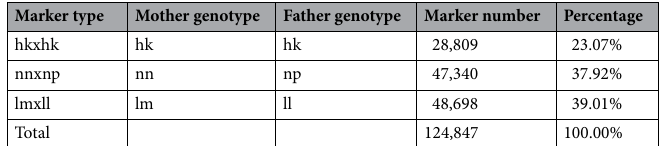
Table 2. Number of genotyping SNPs in each segregation types in F 1